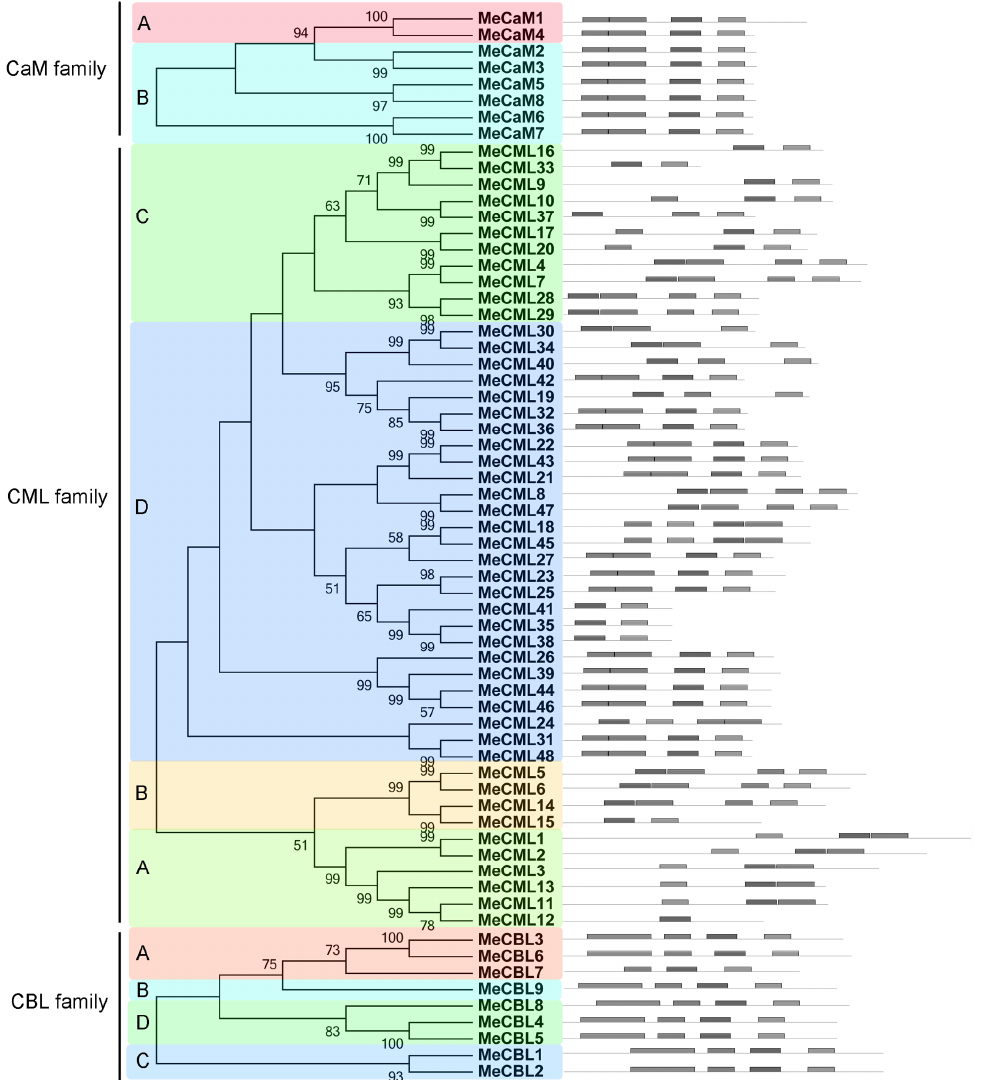
Figure 2. The conserved motifs of cassava CaMs, CMLs, and CBLs according to phylogenetic relationship. All the grey boxes indicate EF-hand domains for each protein. All motifs were identified by MEME database with the complete amino acid sequences of cassava CaMs, CMLs, and CBLs. Each family showed similar motif organization. Shade areas with different colors indicate distinct groups of CaM, CML, and CBL families.